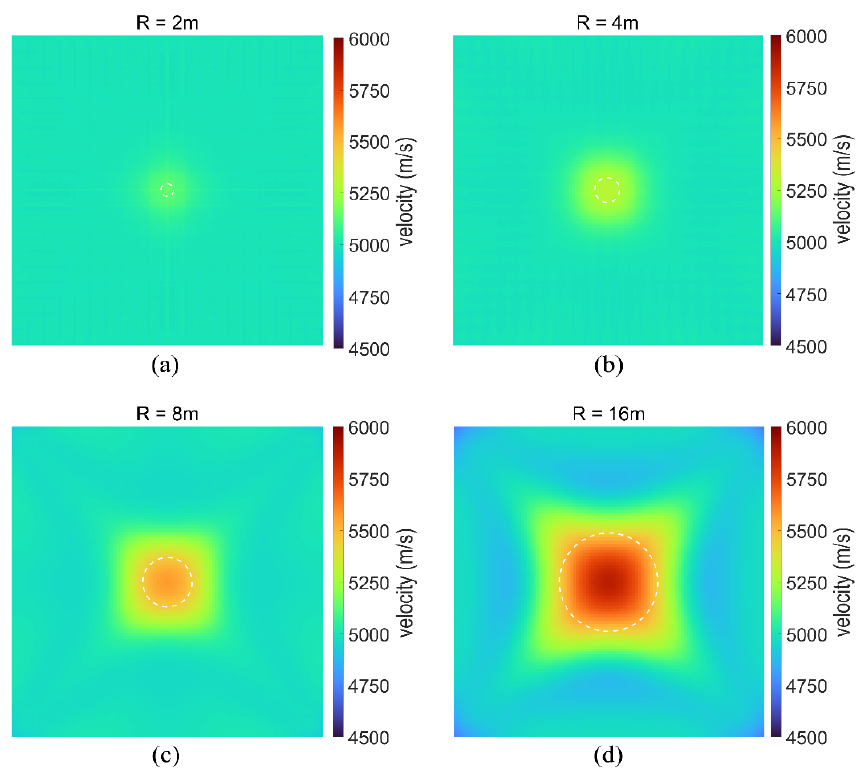
Figure 5. Tomographic results obtained by TDAT with different sizes of anomalous area. R: radius of circular abnormal area.